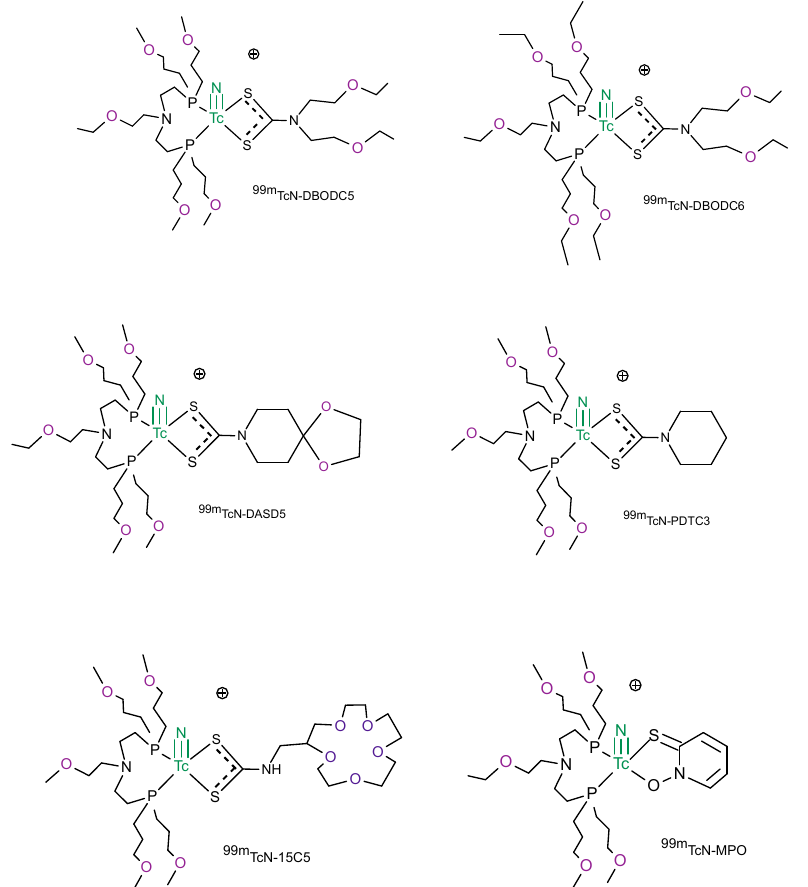
Figure 3. Chemical structures of the most representative [ 99m Tc][TcN-PNP] monocationic myocardial perfusion imaging